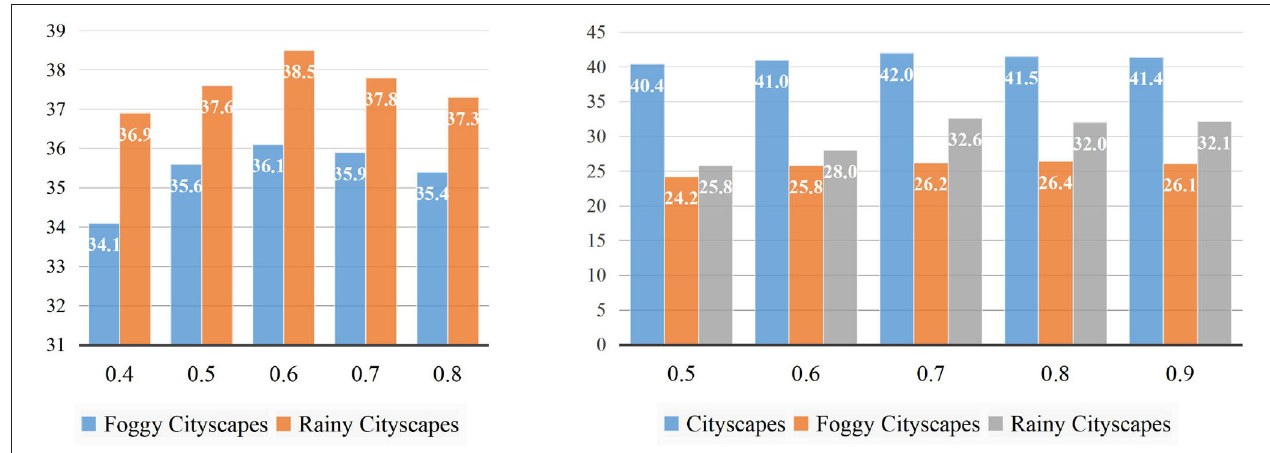
FIGURE 6 | The mAP on all target domains with different confidence thresholds. The left belongs to the experiments “Diverse Weather” (from Cityscapes to Rainy-Cityscapes) while the right is “Virtual-to-Real” (from Sim10K to Rainy-Cityscapes). The vertical and horizontal axis represents overall performance (mAP) and different choices of confidence